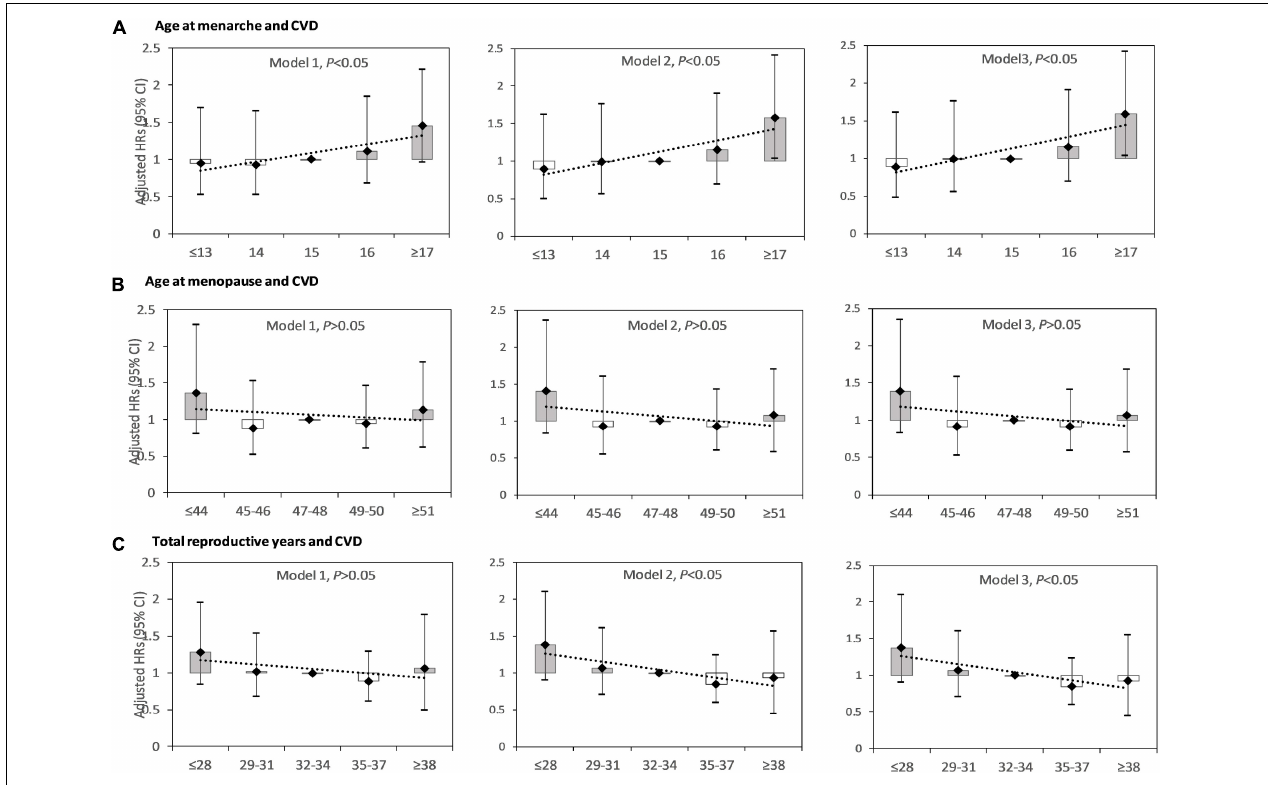
FIGURE 2 | Hazard ratios (HRs) for cardiovascular disease (CVD) by age at menarche, age at menopause, and reproductive lifespan among postmenopausal women. (A) HRs for CVD by age at menarche; (B) HRs for CVD by age at menopause; (C) HRs for CVD by reproductive lifespan. Model 1: adjusted for age at recruitment. Model 2: model 1 plus region, ethnicity, marital status, body mass index, waist circumference, education level, alcohol drinking, smoking, comorbidity, pharmacological treatment, family history of CVD. Model 3: model 2 plus pregnant, contraceptive use status, and breastfeeding experience,